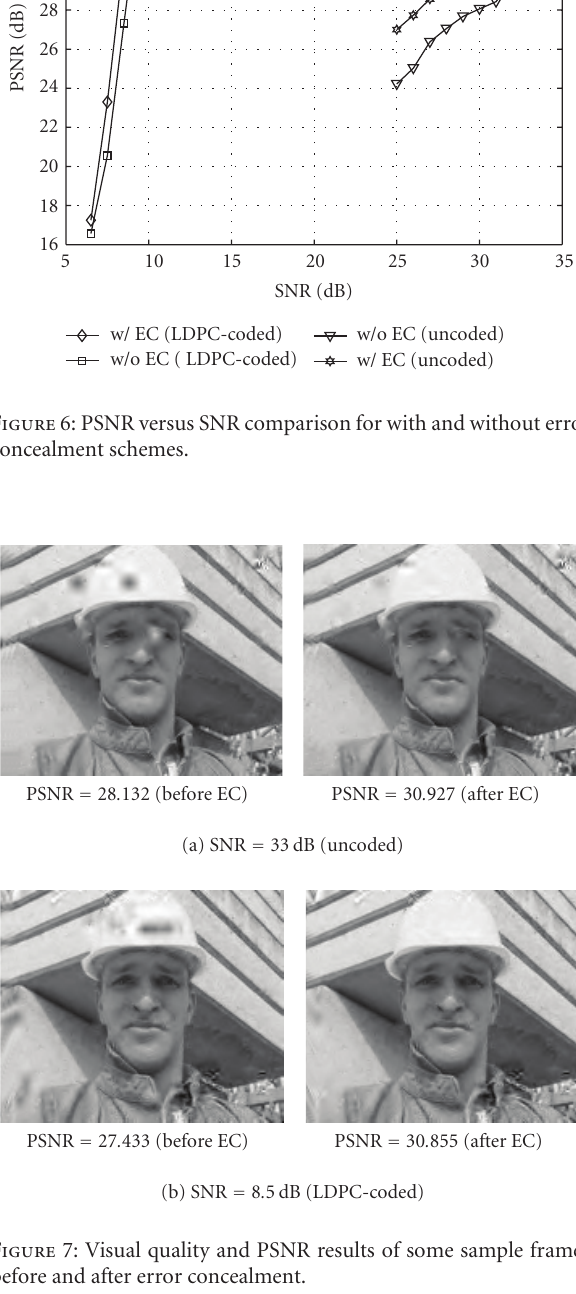
Figure 7: Visual quality and PSNR results of some sample frames before and after error